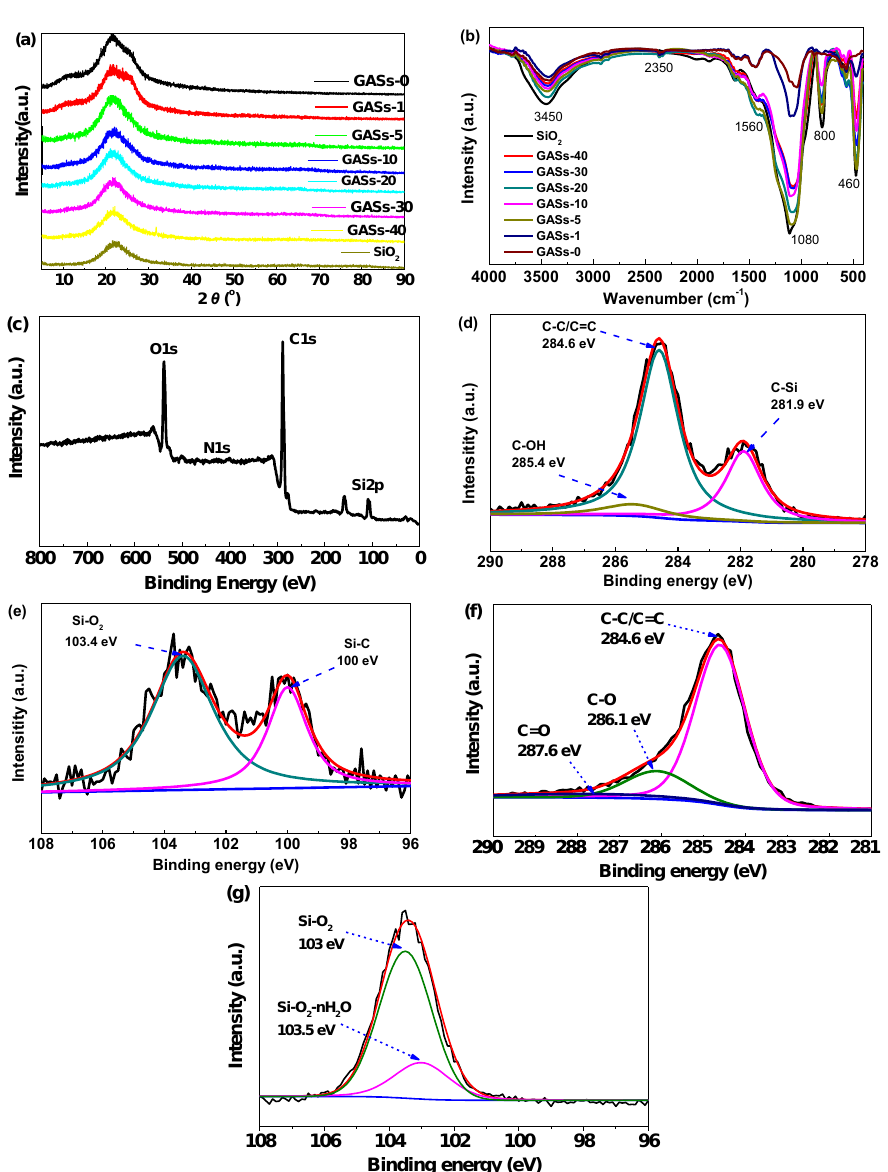
Figure 3. Comparative chemical composition and structural characterizations. ( a ) XRD patterns of GSAs; ( b ) FT–IR spectrum of GSAs; ( c ) XPS survey with all the characteristic peaks of GSA-10; ( d ) and ( e ) deconvolution XPS spectrum of C1s and Si 2 p of GSA-10, respectively. Deconvolution XPS spectrum of ( f ) C 1 s of GAS-0 and ( g ) Si 2 p of SiO 2 .